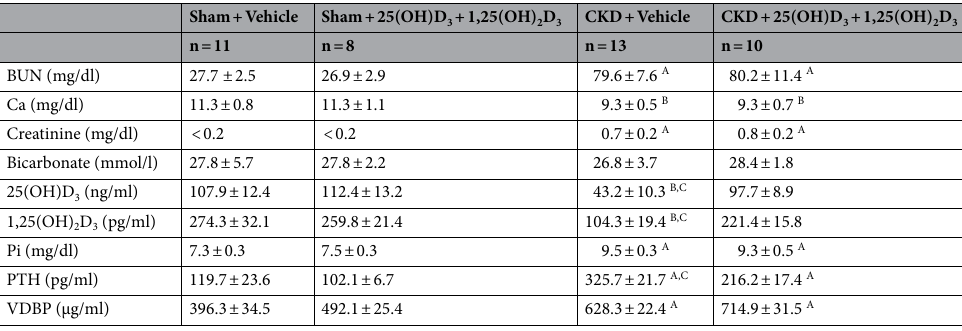
Table 1. Serum and blood chemistry of mice. Sham and CKD mice were treated with 25(OH)D 3 and 1,25(OH) 2 D 3 (75 μg/kg per day and 60 ng/kg per day, respectively) or ethylene glycol as vehicle for 6 weeks. Data are expressed as mean ± SEM. A p < 0.05, significantly higher in CKD + Vehicle and CKD + 25(OH) D 3 + 1,25(OH) 2 D 3 mice versus Sham + Vehicle and Sham + 25(OH)D 3 + 1,25(OH) 2 D 3 mice, respectively. B p < 0.05, significantly lower in CKD + Vehicle and CKD + 25(OH)D 3 + 1,25(OH) 2 D 3 mice